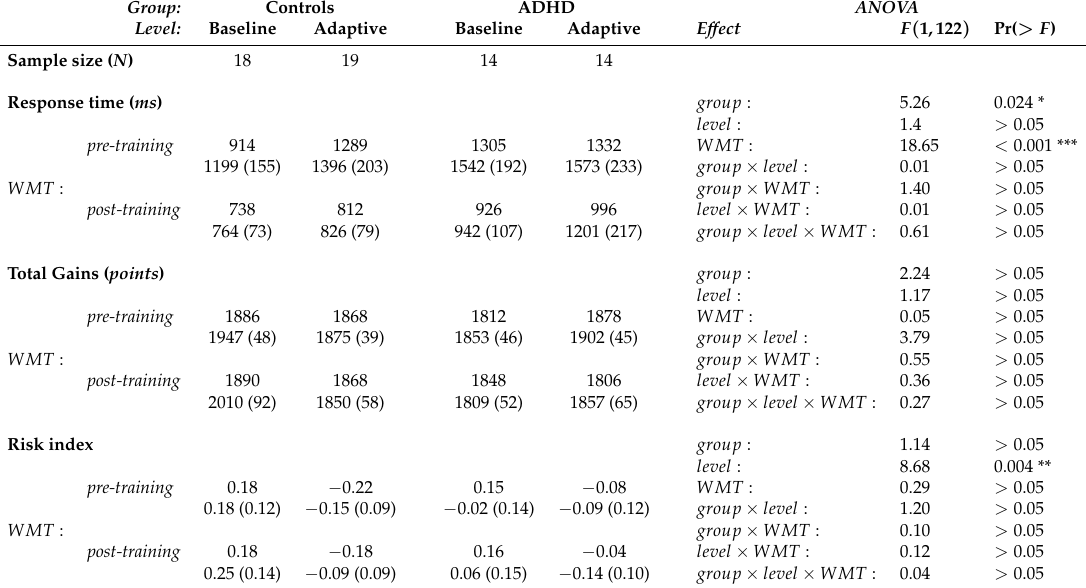
Table 2. Pre and post-training performance (median, mean and SEM) during the probabilistic gambling task and results of the three-way analysis of variance